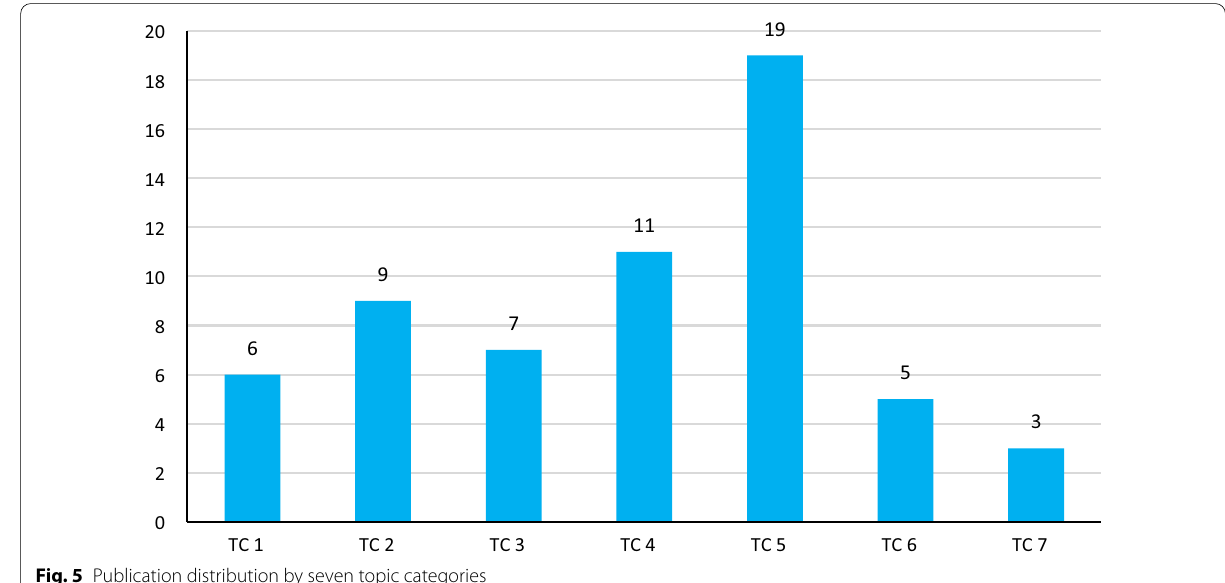
Fig. 5 Publication distribution by seven topic categories